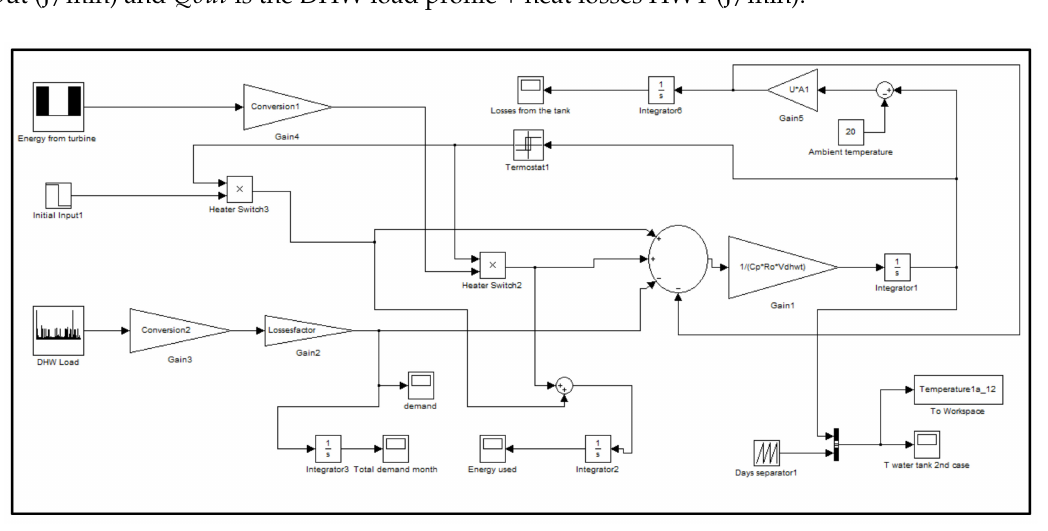
Figure 9. Matlab-Simulink model created for investigating the feasibility of first and second